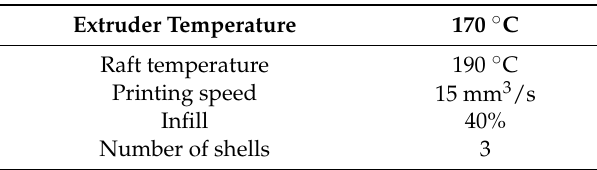
Table 1. Printing parameters used for